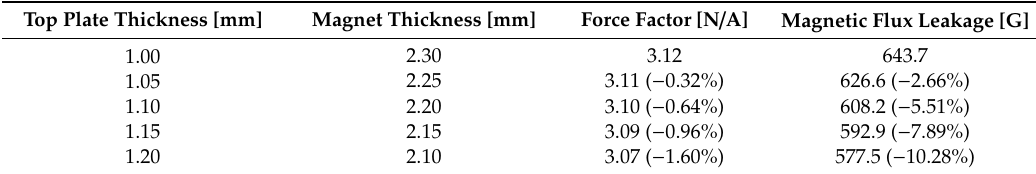
Table 3. Analysis results with different top plate thicknesses.